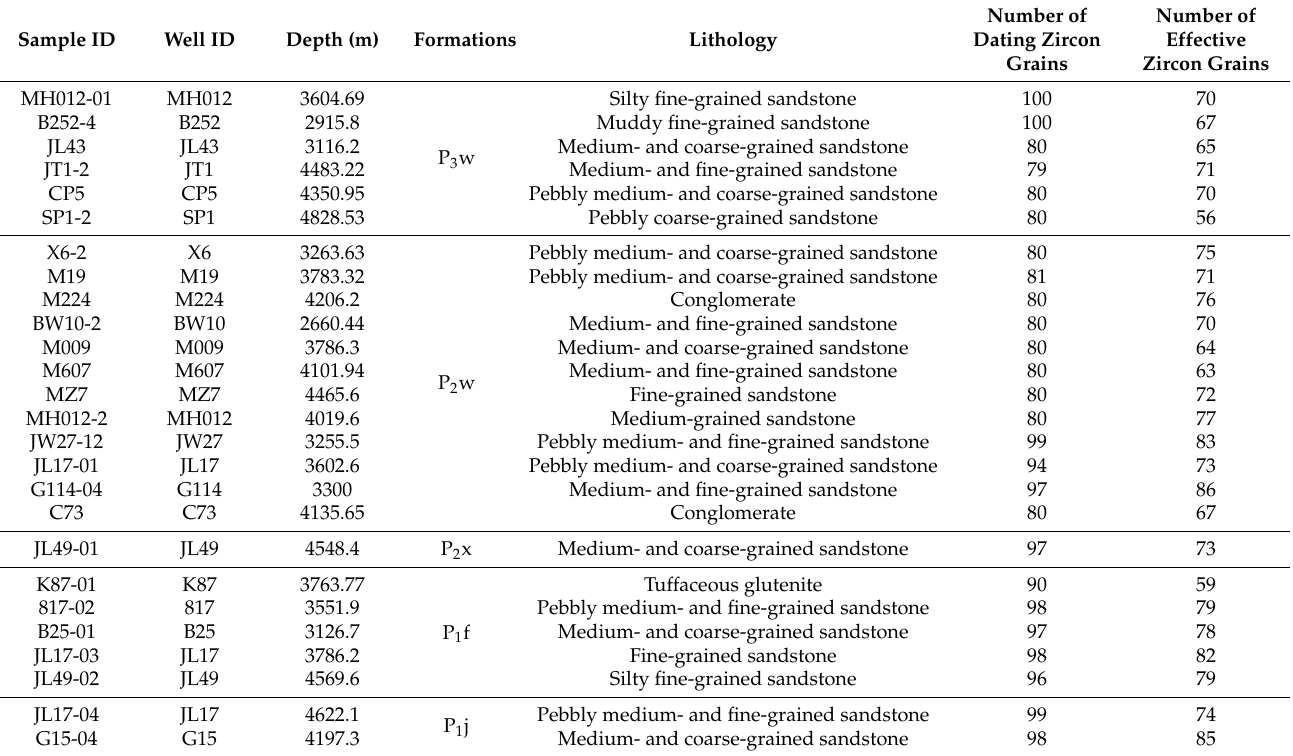
Table 1. Information on samples used for laser ablation inductively coupled plasma mass spectrometry dating of detrital zircons in the Mahu-Zhongguai area on the northwestern margin of the Junggar